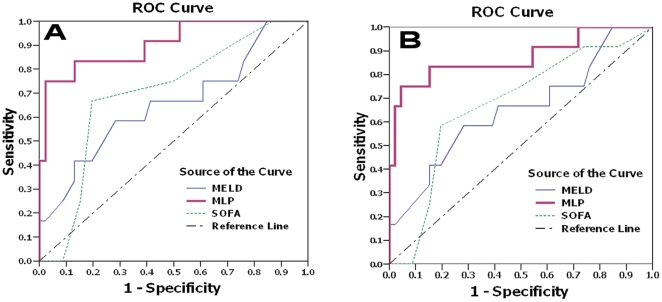
ROC curves for MLP, SOFA score, and MELD score in posttransplant survival prediction.(3A): Posttransplant one-year prediction. (3B): Posttransplant two-year prediction.